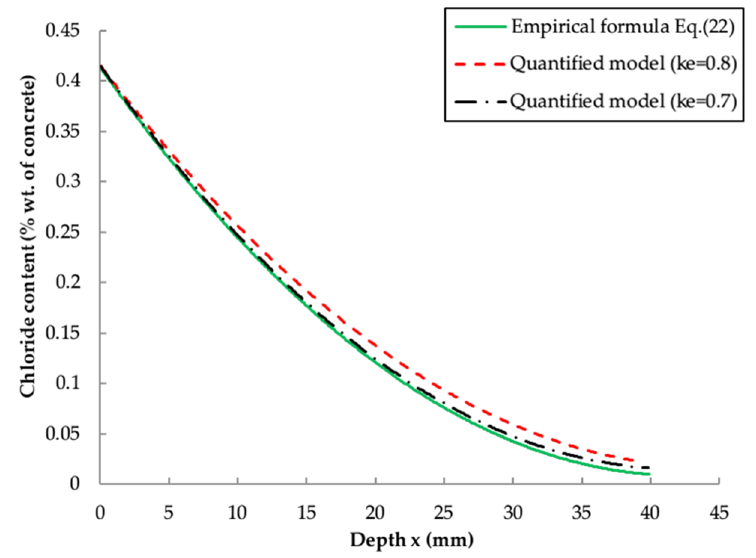
Figure 7. Comparison between empirical formula (Equation (22)) and quantified model (Equation (25)).